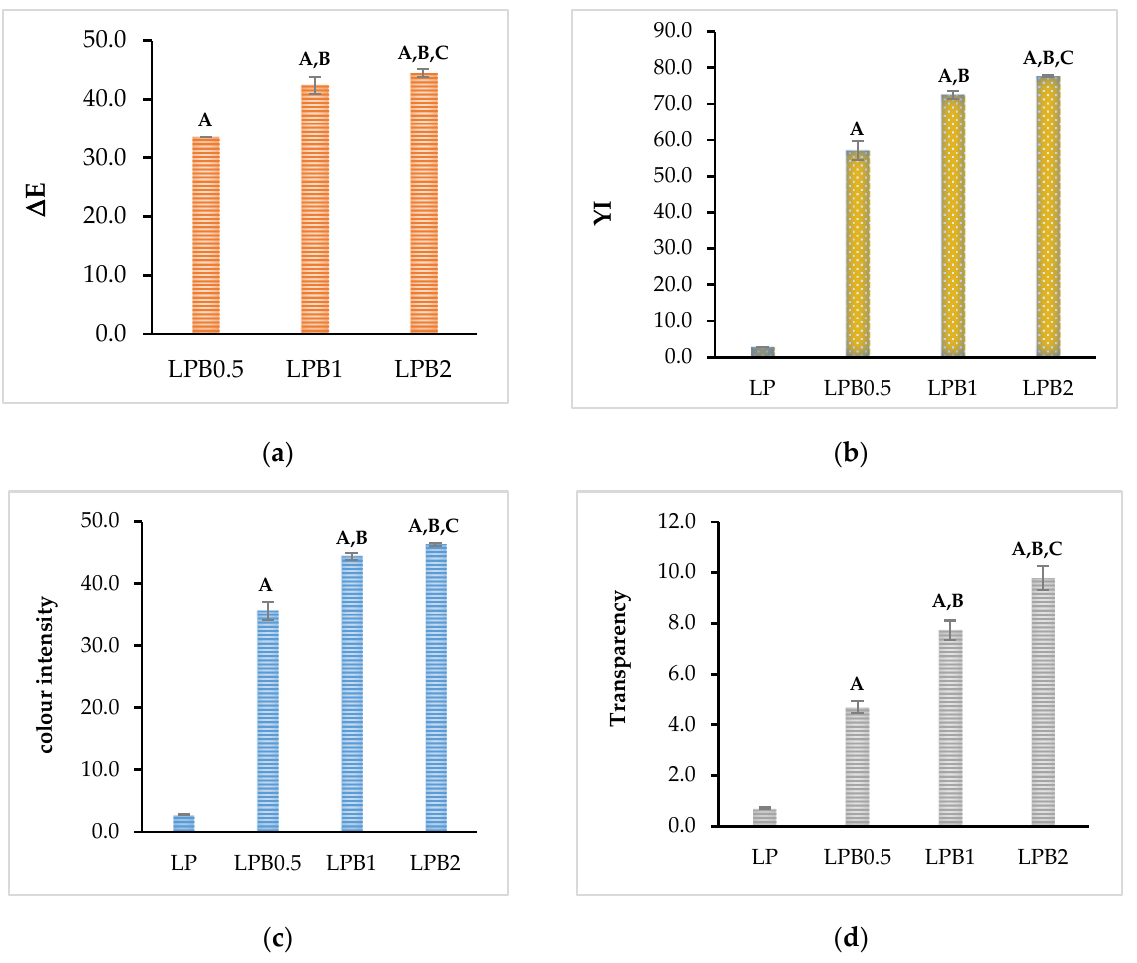
Figure 7. Colour parameters ( a ) Δ E, ( b ) YI, ( c ) colour intensity, and ( d ) transparency of studied polymeric films ( p < 0.05, indicates statistically significant differences in comparison: A—to LP film, B—to LPB0.5 sample, C—to LPB1 material).